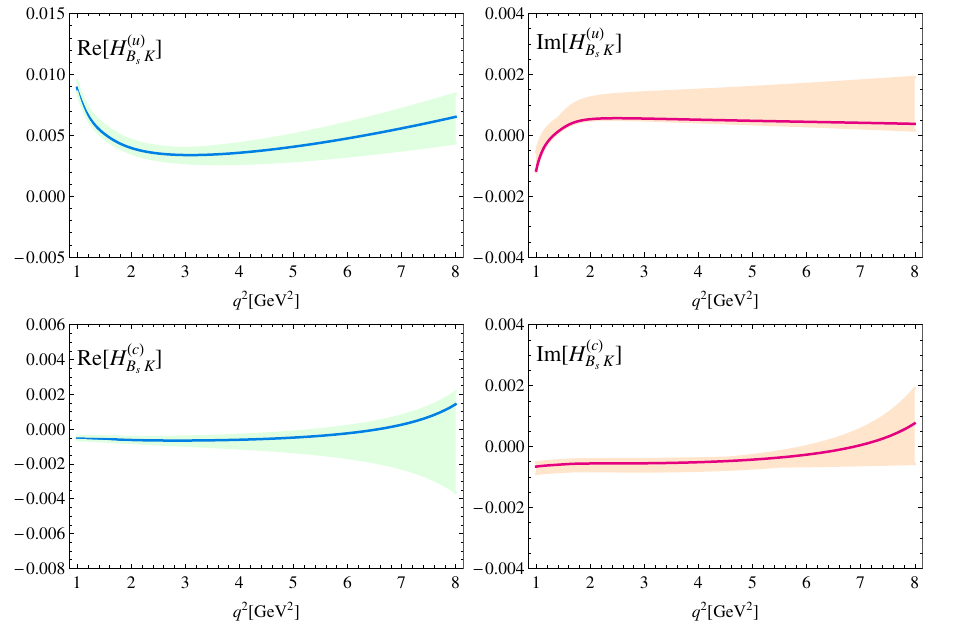
Figure 4 . The same as in (cid:12)gure 2 for the amplitudes H ( u )